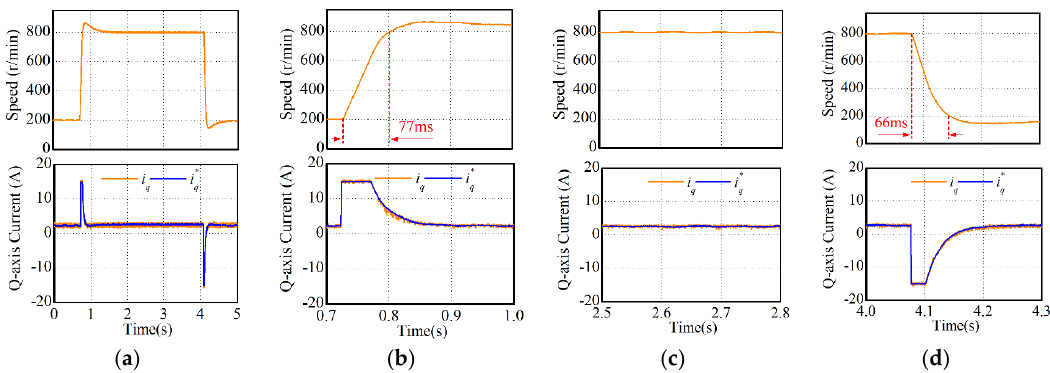
Figure 11. Speed response with accurate measurement: ( a ) 0 – 5 s, ( b ) 0.7 – 1.0 s, ( c ) 2.5 – 2.8 s, ( d ) 4.0 – 4.3 s.